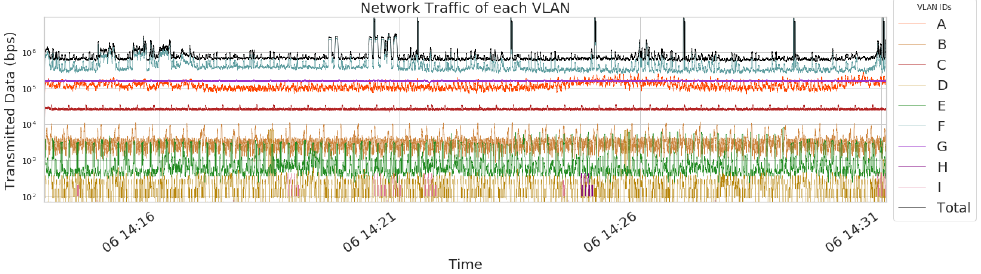
Figure 6. Traffic per Virtual Local Area Network (VLAN); illustrated in logarithmic scale.